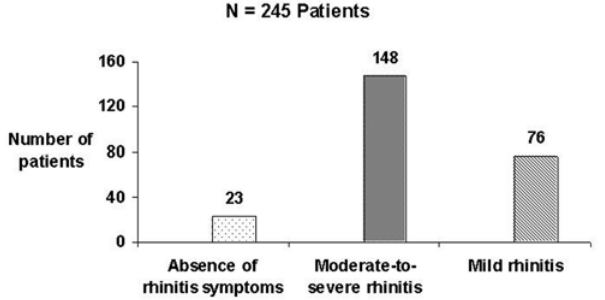
Figure 2 - Severity of rhinitis symptoms among severe asthma patients (defined according to the criteria established in Allergic Rhinitis and its Impact on Asthma – ARIA 7 ).